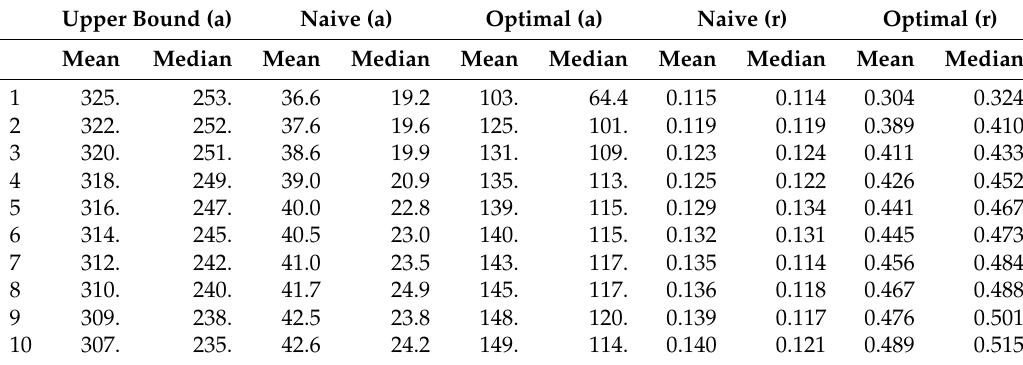
Table 1. Mean and median results for various sampling rates. The first column contains the sampling period in minutes. Columns marked with (a) contain absolute improvements over the self-consumption before load shifting, measured in Wh/day. Columns marked with (r) contain relative values, which are normalized with the upper bound